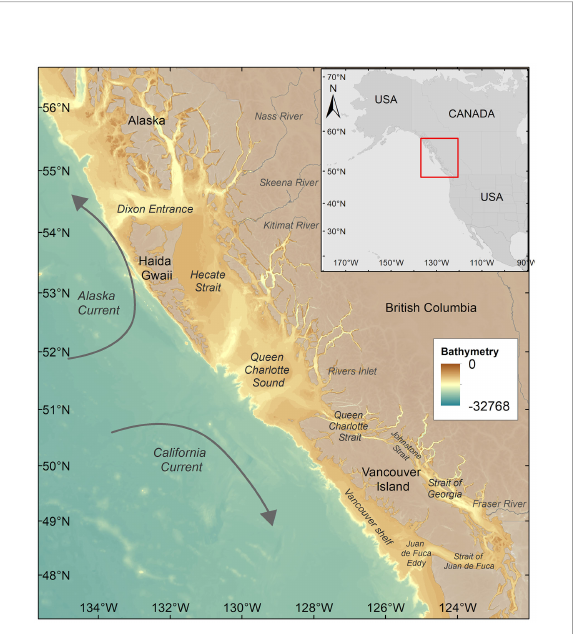
FIGURE 1 Study area map showing the two main currents (i.e., Alaska current and California current) and the bathymetry of the region. The names of the main rivers and locations cited in the text are also